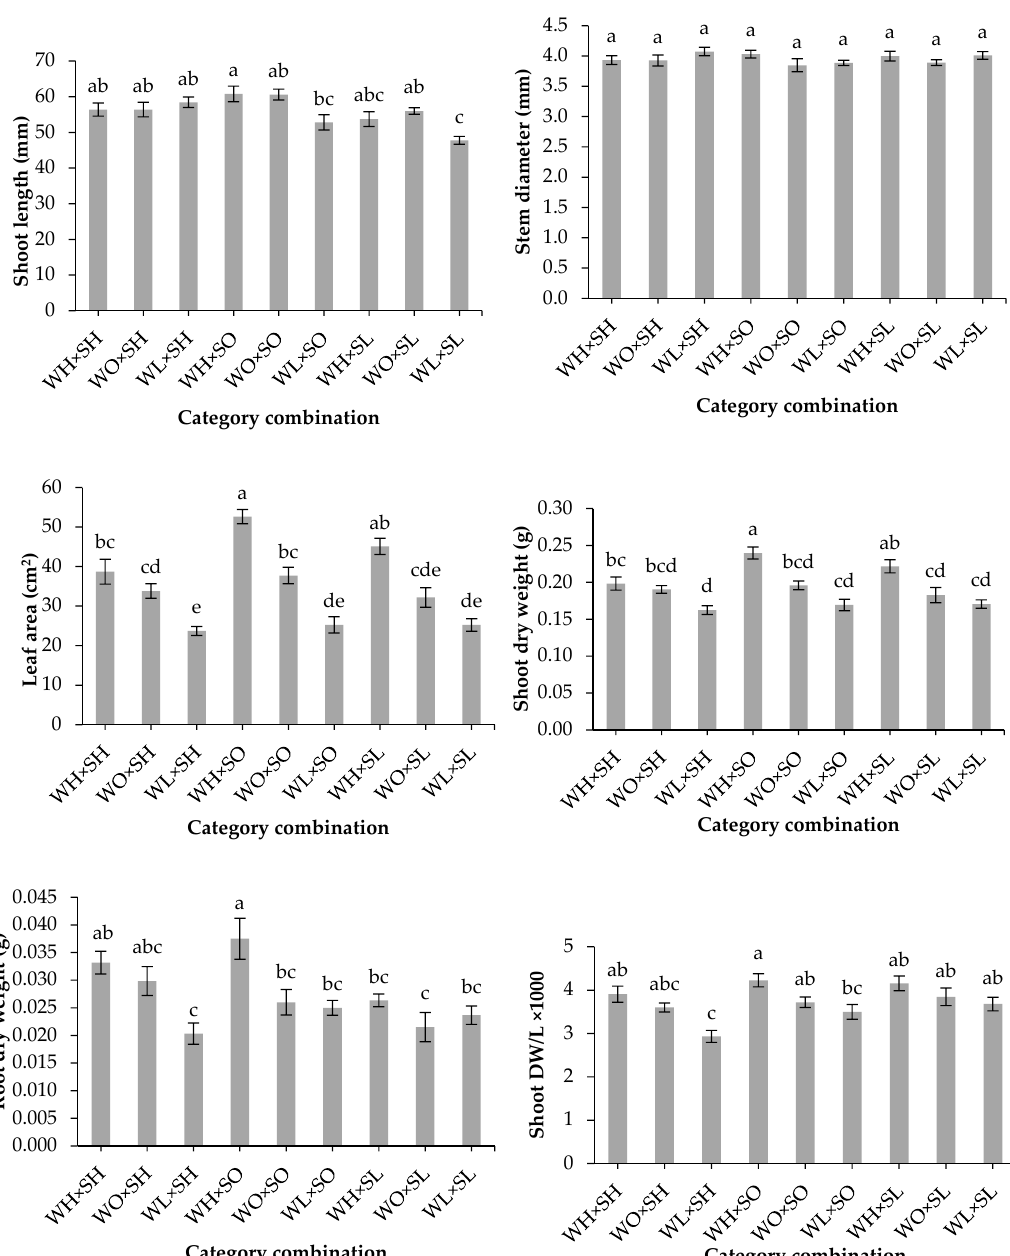
Figure 2. Morphological, growth, and developmental parameters of nine quality category combinations of grafted watermelon seedlings 7 days after grafting, as described in Table 1. DW / L: shoot dry weight-to-length ratio. Bars followed by di ff erent letters are significantly di ff erent ( α ≤ 0.05). Each mean value was computed from n = 12 seedlings. Error bars correspond to the standard error (SE) of the